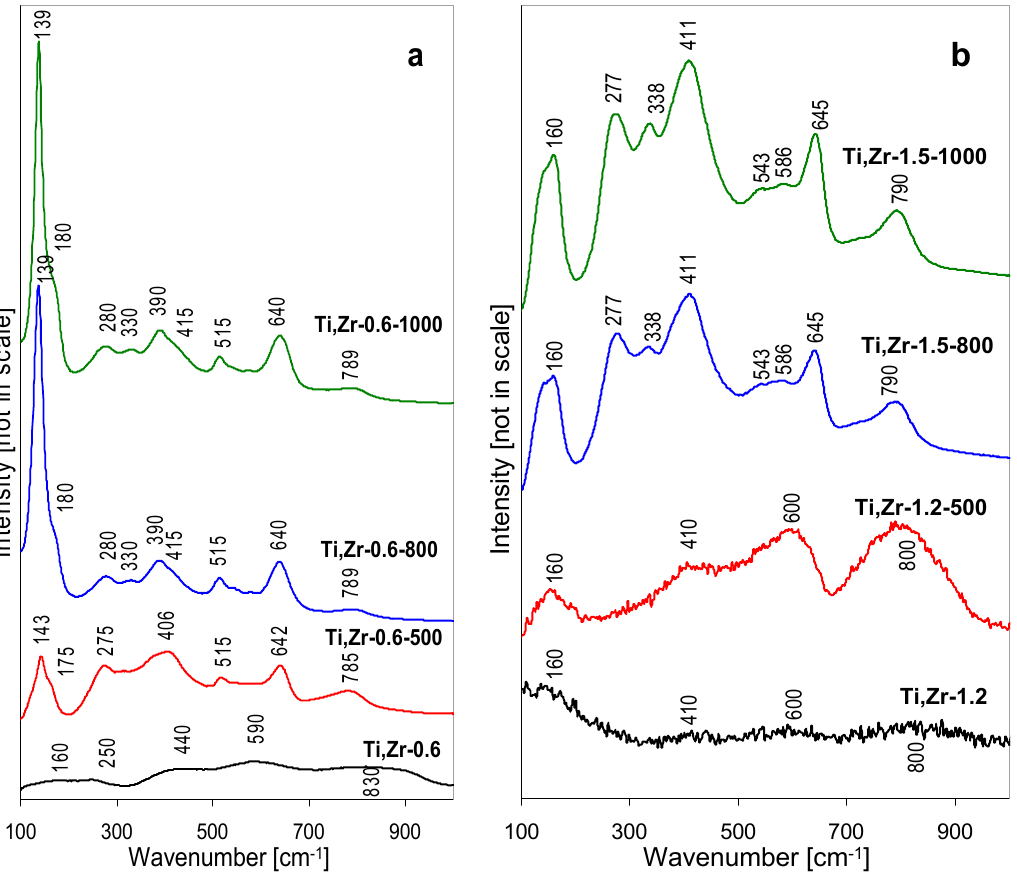
Figure 8. Raman spectra illustrating the effect of thermal treatment on hydrolysates obtained by lyophilization of Ti, Zr-pillaring solution: ( a ) As received at pH = 0.6, ( b ) after pH adjustment to 1.2.